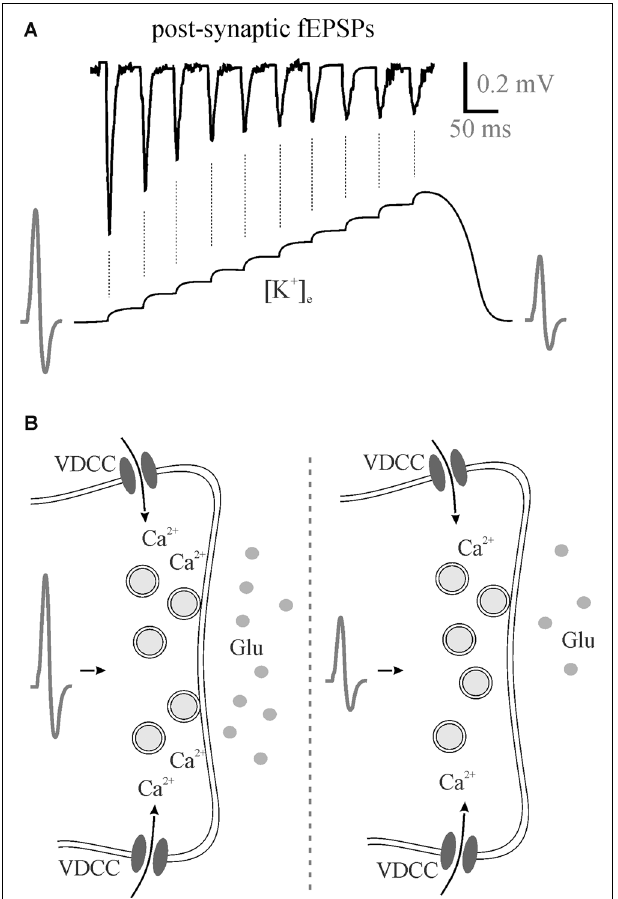
FIGURE 2 | Perisynaptic K + buildup can decrease neurotransmitter release. (A) 50 Hz stimulation trains lead to the accumulation of extracellular K + that theoretically depolarizes membranes reducing presynaptic action potentials with a subsequent reduction in neurotransmitter release as evident by post-synaptic fEPSPs. (B) A hypothesized reduction in action potential amplitude means less Ca 2+ entry through voltage-gated calcium channels for less vesicular neurotransmitter release. fEPSPs, field excitatory postsynaptic potentials; Glu, glutamate; VDCC, voltage-gated calcium channel.